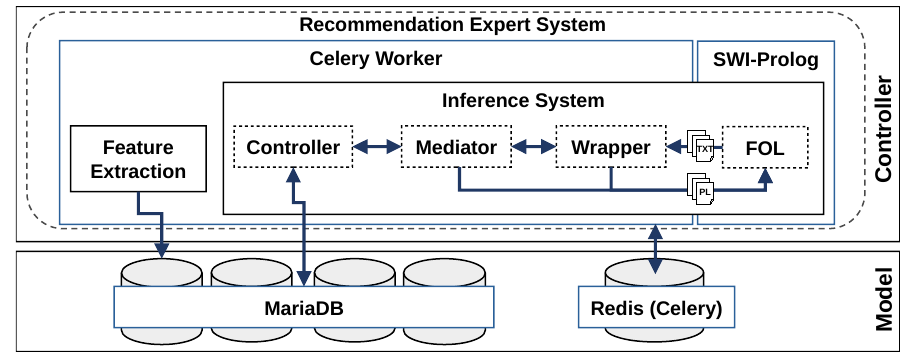
Figure 14. Details of the recommendation expert